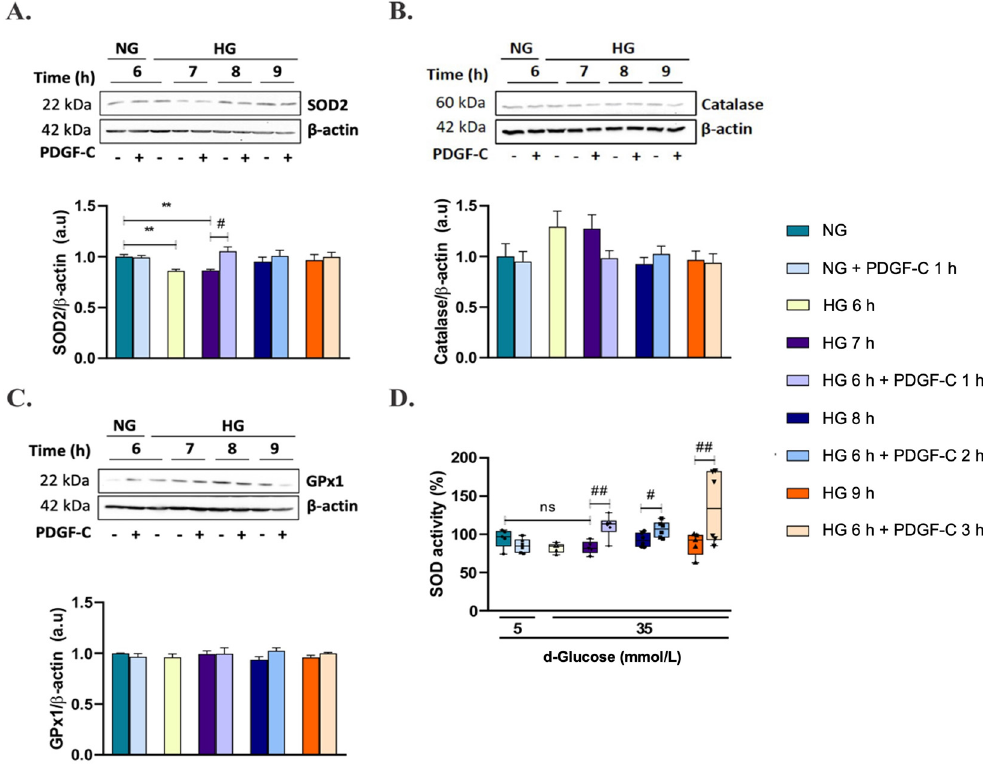
Figure 4. Effect of PDGF-C on antioxidant enzyme expression and SOD activity in endothelial cells treated with high glucose. HAECs were seeded in 6-well plates and exposed to 35 mmol/L d-glucose for 6 to 9 h without and with 50 ng/mL PDGF-C and ( A ) SOD2, ( B ) catalase, and ( C ) GPx1 expression was evaluated by Western blot. Images correspond to representative Western blots for each enzyme. Densitometry analysis corresponds to the band of each enzyme normalized with the band of β -actin for at least 3 independent experiments. Data are presented as the mean ± SEM of at least three independent experiments (** p < 0.01 regarding NG, # p < 0.05 regarding HG). In the same conditions mentioned above, cells were lysed and ( D ) SOD activity was measured by colorimetric assay. Data are presented as the mean of % of inhibition of formazan formation by SOD ± SEM of at least three independent experiments (## p < 0.01, # p < 0.05 regarding HG, ns: non-significant).